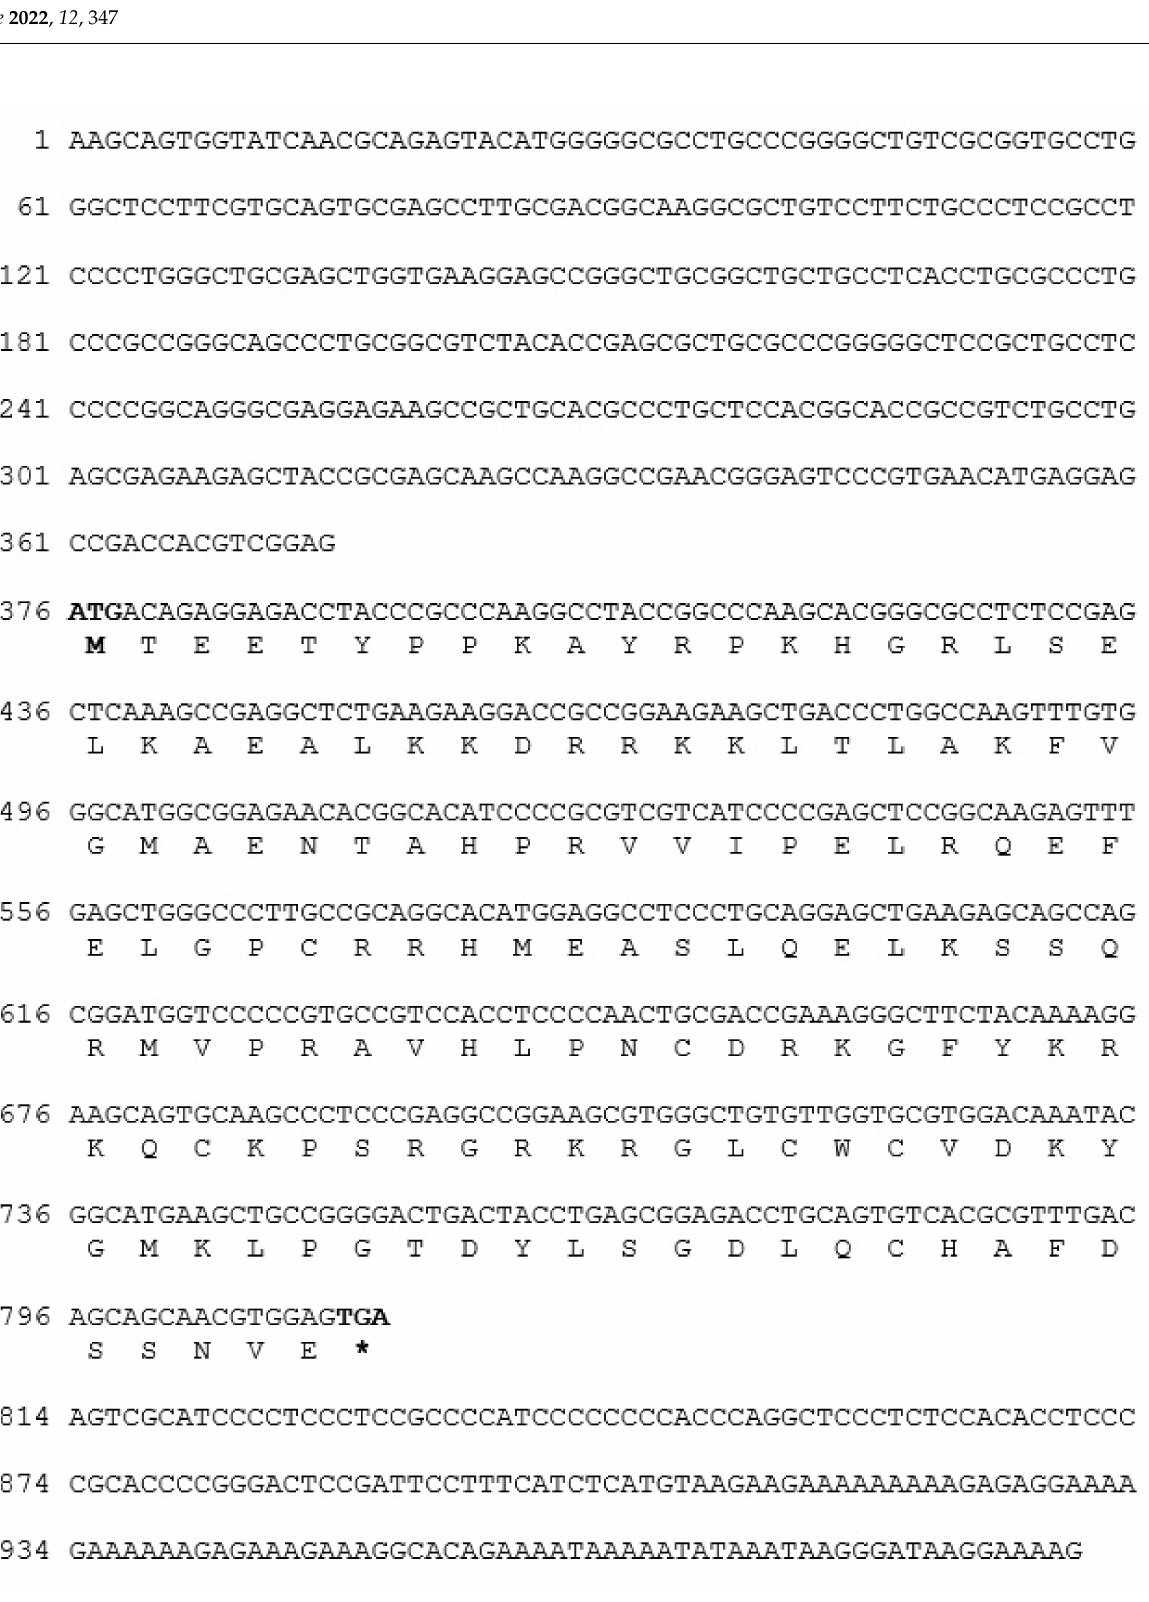
Figure 2. The scheme showing the full-length mRNA sequence and the predicted protein sequence of the goose IGFBP5 gene. Note: The ATG and TGA in bold fond indicate the start codon and stop codon, respectively. The sequence before the start codon is the 5 (cid:48) -UTR, and the sequence after the stop codon is the 3 (cid:48)